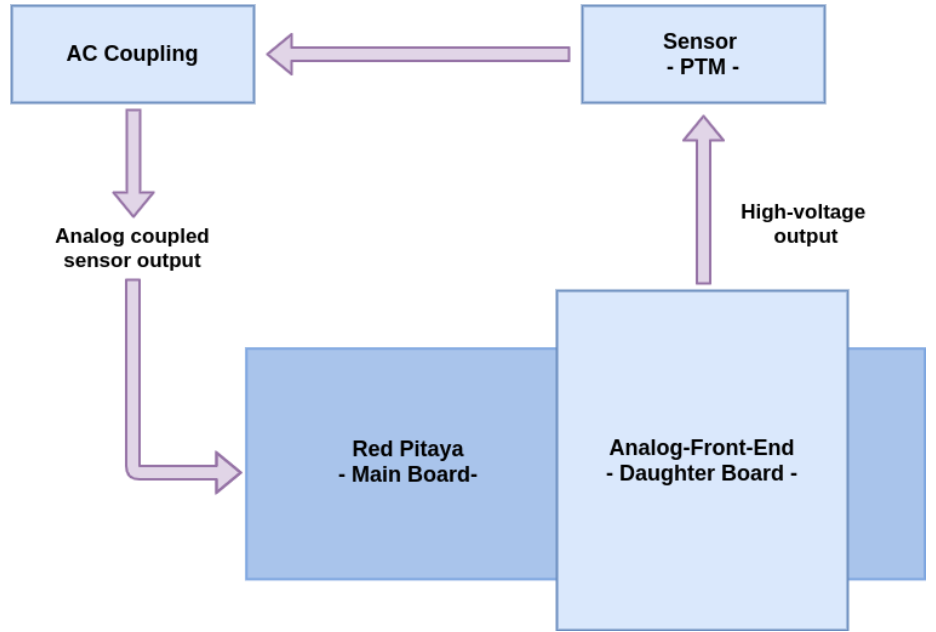
Figure 1. Block diagram of the data acquisition system (DAQ) for the water Cherenkov detector (WCD) used to collect the